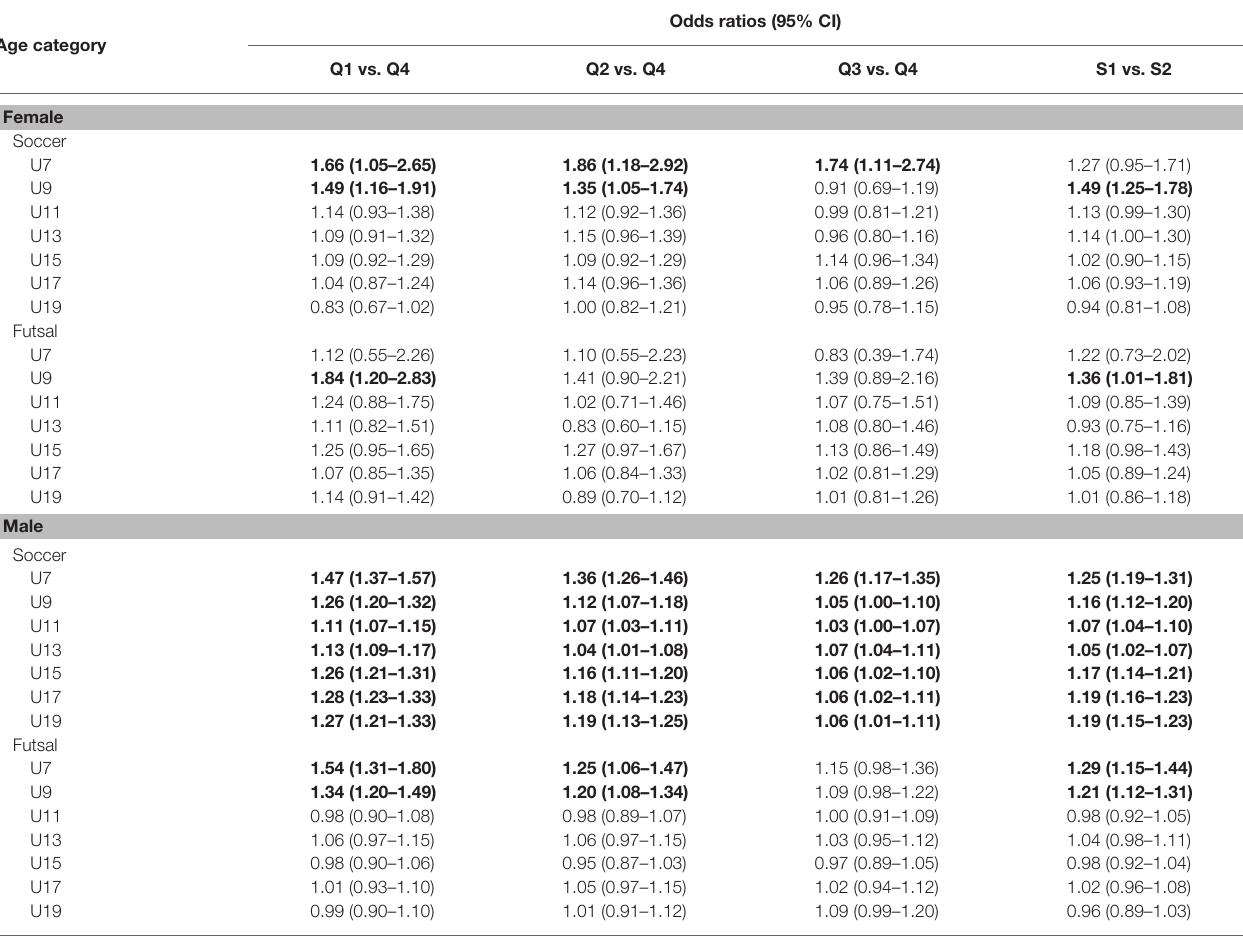
TABLE 2 | Odds ratios (OR; 95% CI) according to players’ age category by gender for youth soccer and futsal players examining relative age effect